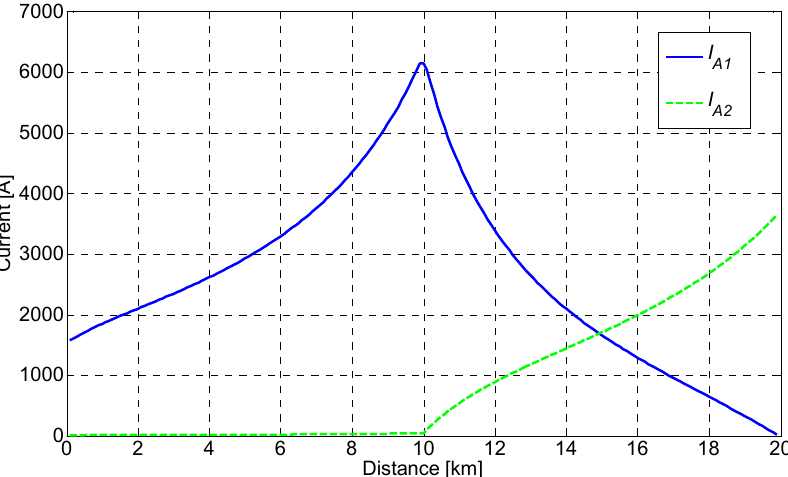
Figure 9. Currents in autotransformers as a function of the distance from the traction substation when a ground fault occurs between the feeder and rail along different zones in a section with two subsections.